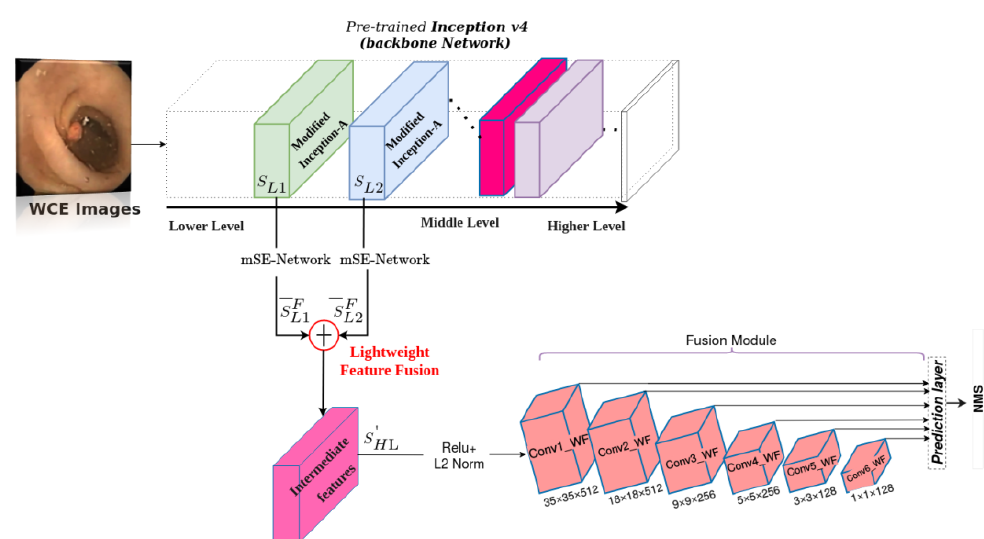
Figure 5. Overview of the Hyb-SSDNet architecture with a 299 × 299 × 3 input size and inception v4 as the backbone. Features from two successive modified inception-A layers ( S L 1 , S L 2 ) were fused by a mid-fusion block producing an intermediate feature representation ( S (cid:48)